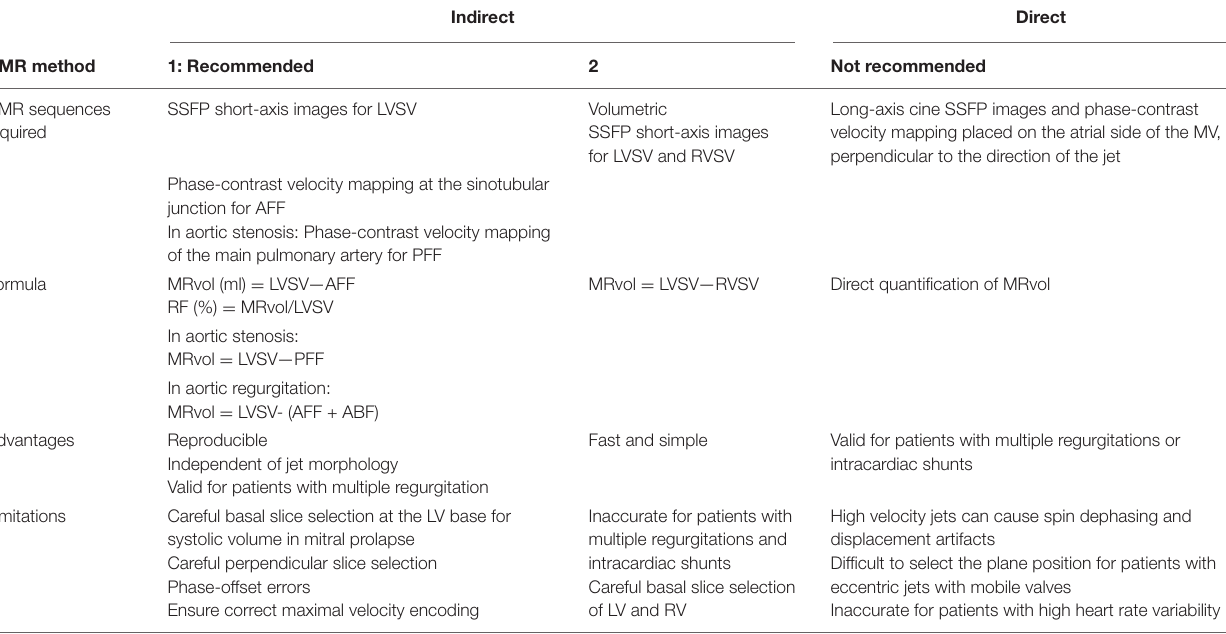
TABLE 1 | Various CMR methods used in clinical practice to quantify MR, with their advantages and